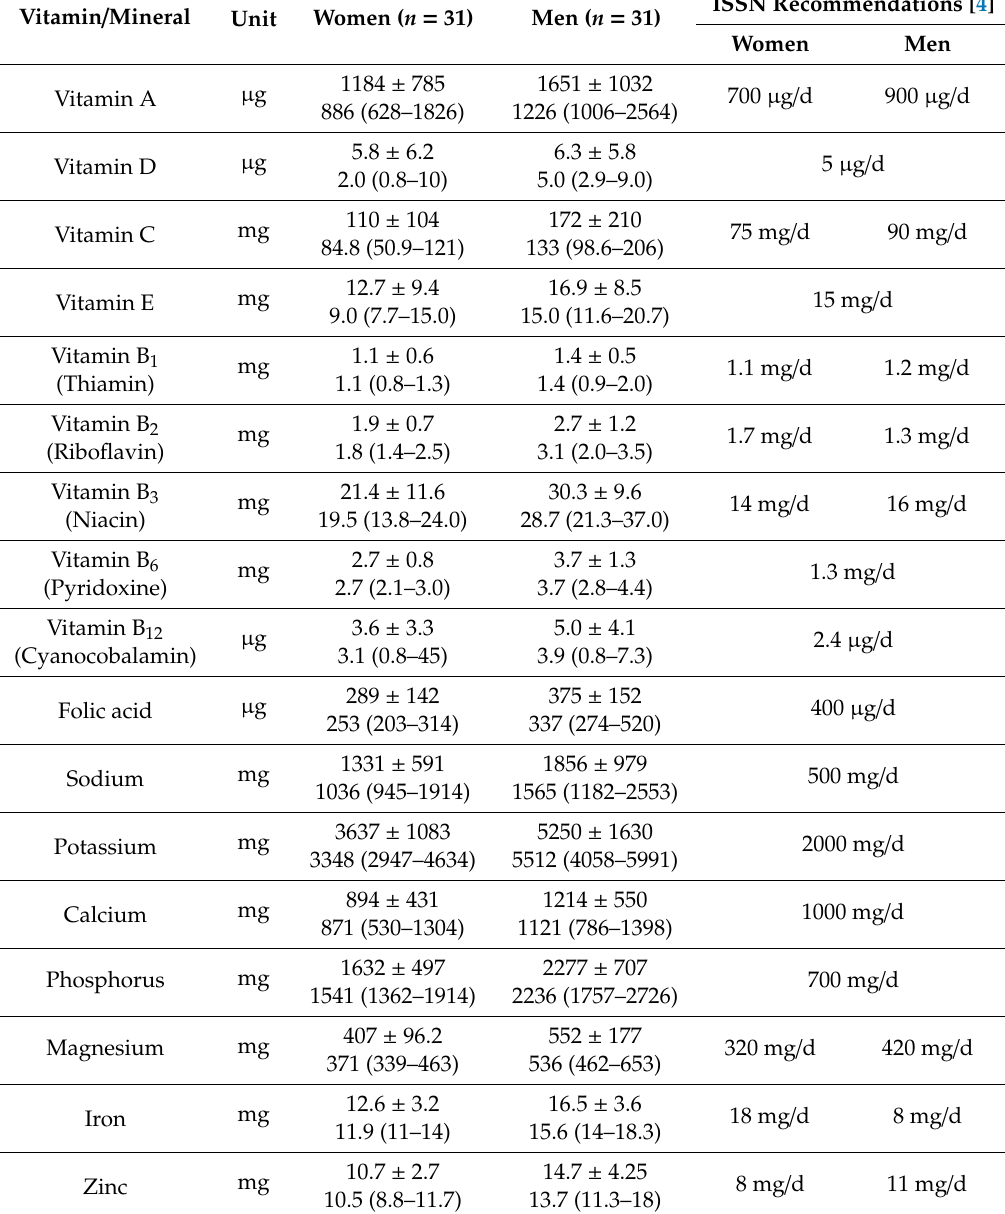
Table 3. Mean values of vitamins and minerals intake in CrossFit